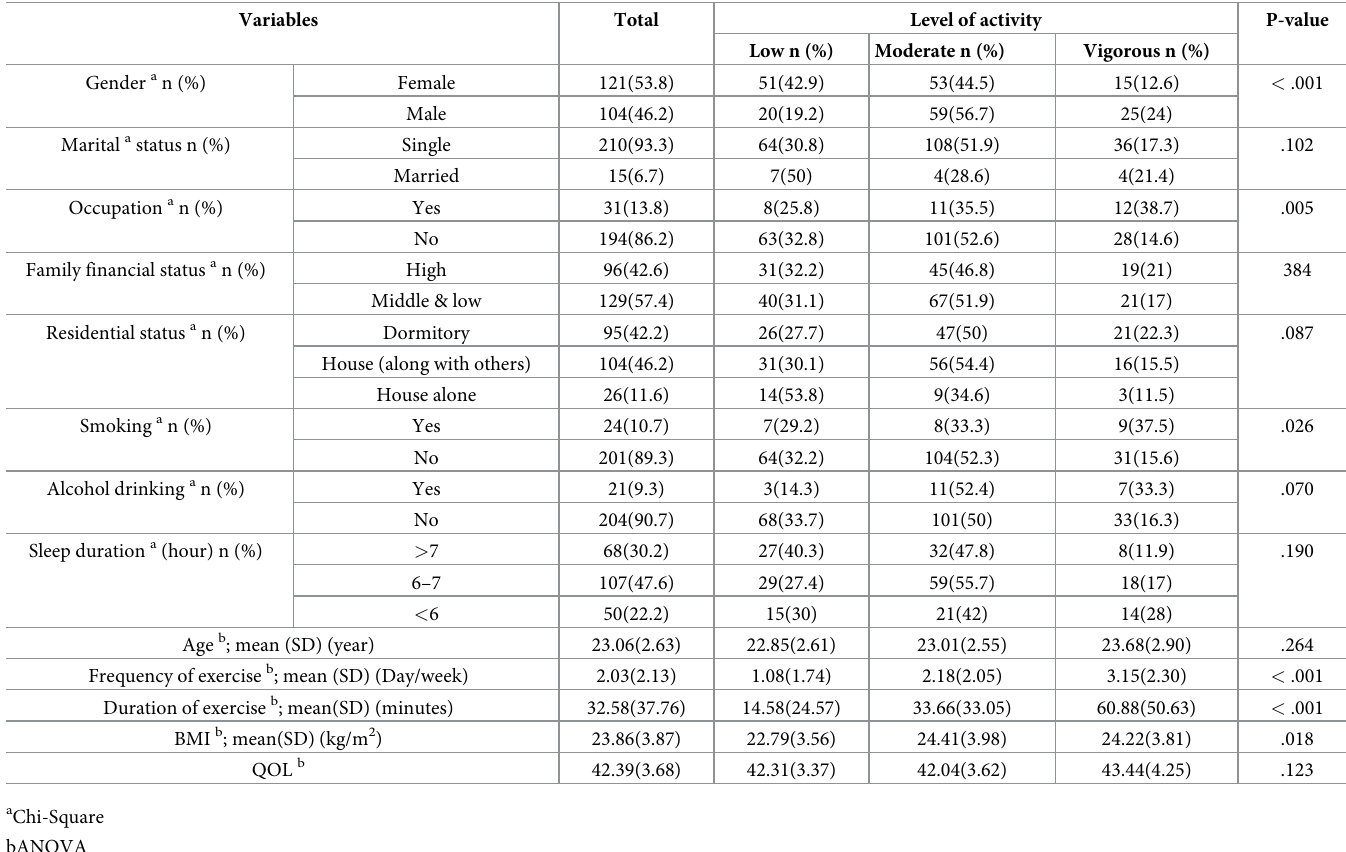
Table 1. Characteristics of the students and its’ association with physical activity levels (N =